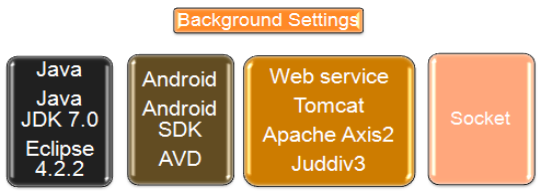
Figure 7. The diagram for background